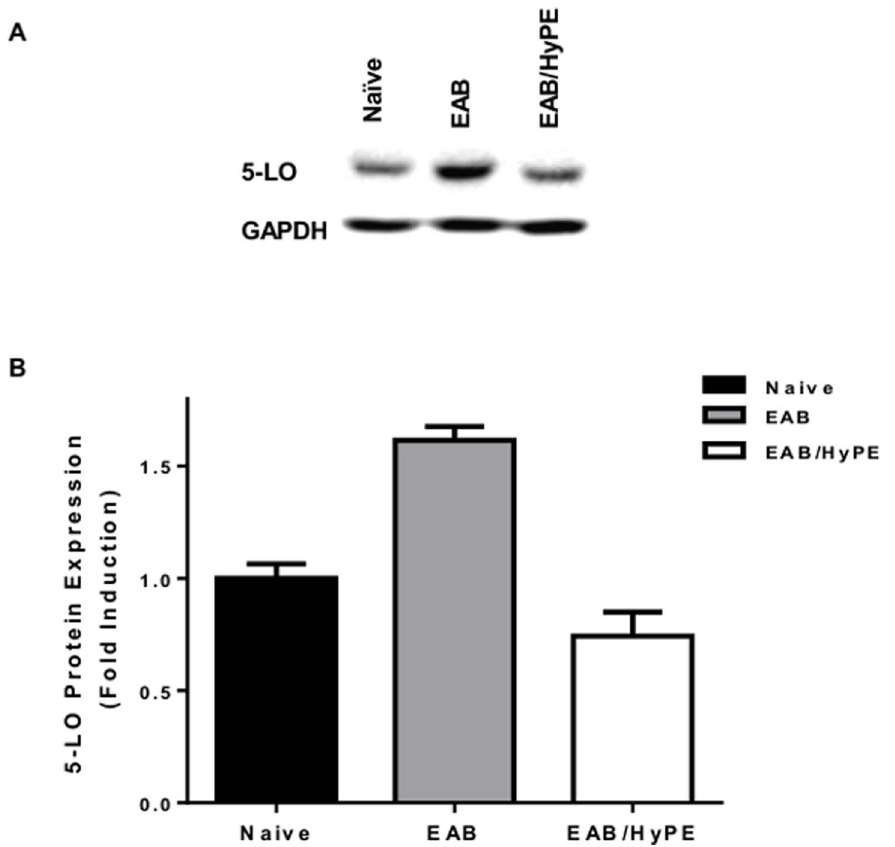
Figure 7. 5-LO protein level in EAB mice lung. 5-LO protein in mice lung homogenates was determined by Western blotting A. Representative blots. B. Blot quantification by densitometry, normalized to GAPDH. Data are mean 6 SEM for 3 independent experiments, normalized to GAPDH. Data are mean 6 SEM for 3 independent experiments. * P , 0.05.